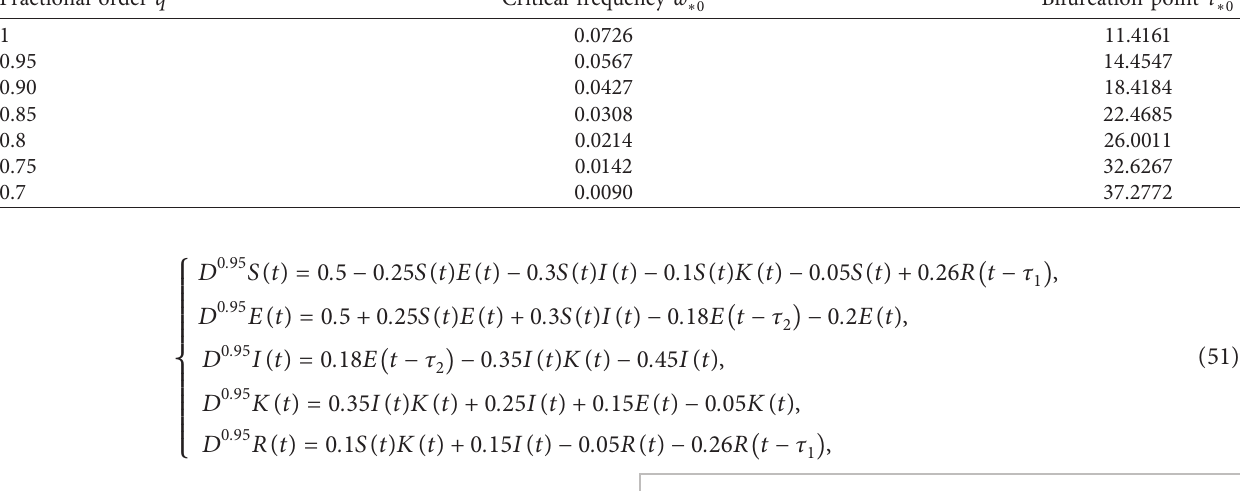
Table 3: Relation of parameters of q, ω